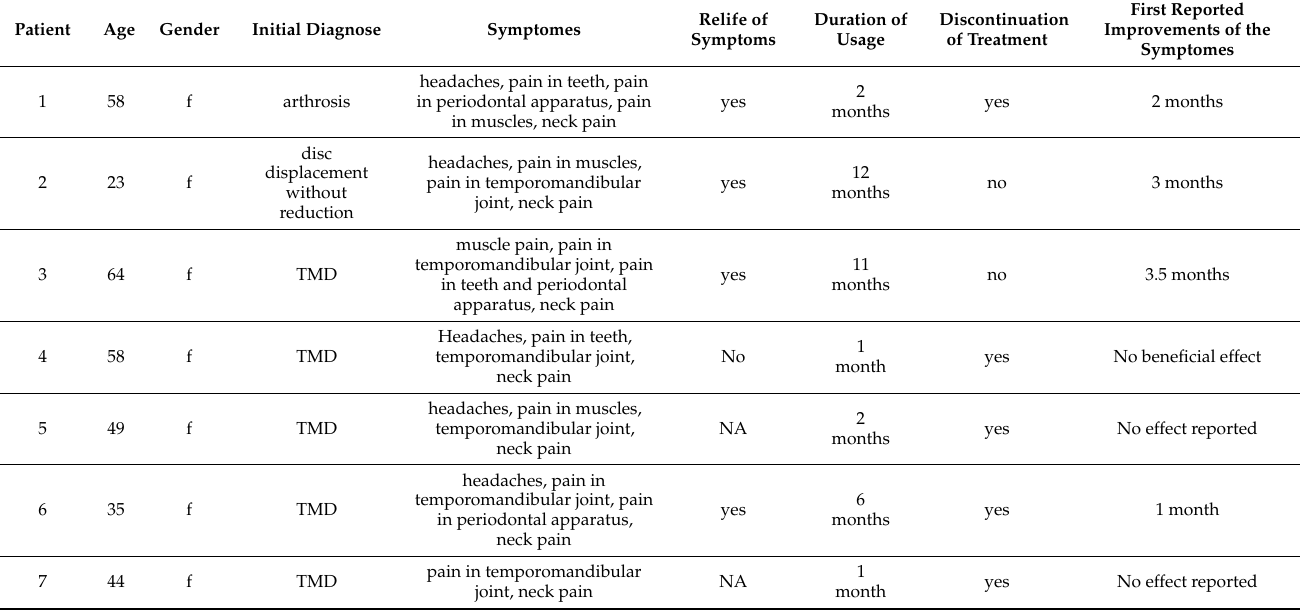
Table 1. Details information about the patient base, their age, gender and their initial symptoms. It also shows how long the devices have been worn and whether or not the treatment got discontinued by the